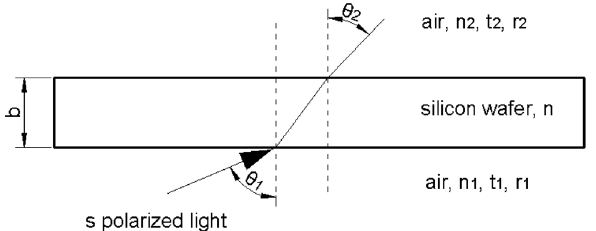
Figure 2. Schematic of reflectance R and transmittance T of s-polarized light transmitting through a thin silicon wafer. The image was created using AutoCAD 2014 (simplified Chinese), http://win.xmjfg .com/pg/246.